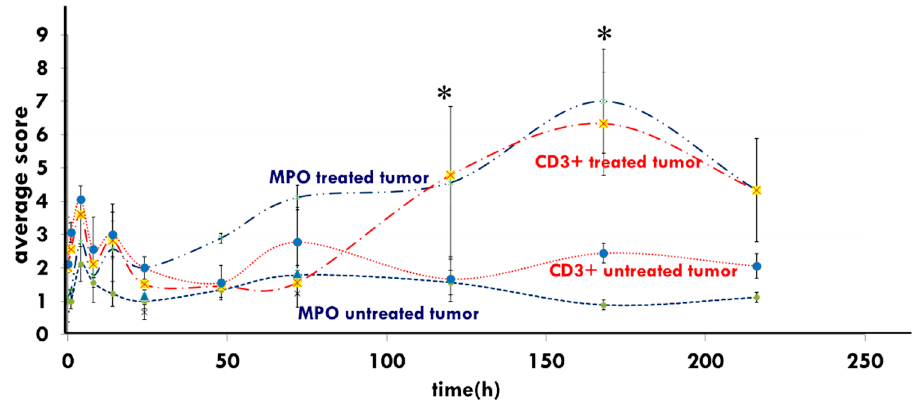
Figure 13. Induced immune reactions appear in both the Myeloperoxidase (MPO) and the CD3 + -T– cells’ peak at one-week post-treatment in the HT29 xenograft [103]. (* means that p < 0.05)